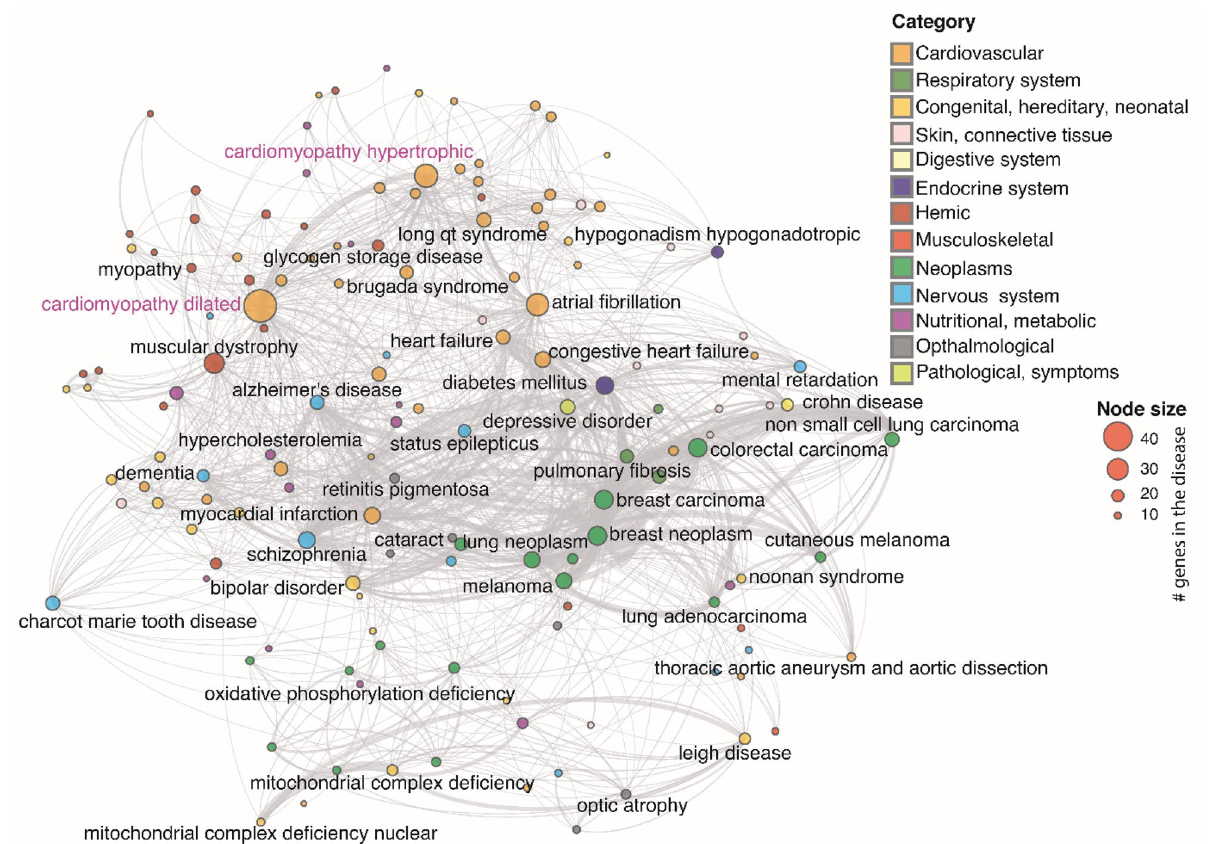
Figure 1. Cardiomyopathy-centric diseasome: A graph representing the cardiomyopathy-centric diseasome network, in which two diseases are linked if a gene is implicated in both diseases. It is constructed by projecting a cardiomyopathy-centric bipartite graph. Each node represents a distinct disease in the network, and it is coloured based on the disease category it belongs to. The size of each node is proportional to the number of genes in that particular disease. The name of diseases with > 20 associated genes are labelled in the network. There are 12 disease categories in the cardiomyopathy-centric diseasome as labelled in the legend. The links between disease pairs are shown in grey colour. The weight of a link is proportional to the number of genes implicated in both